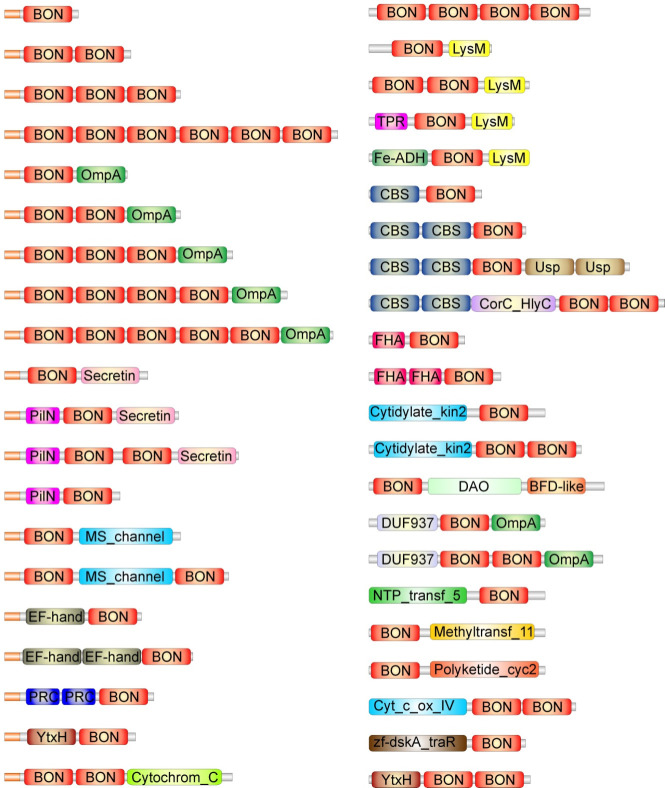
BON domain (Pfam: PF04972) containing proteins.The Pfam database was interrogated for the presence of proteins containing BON domains. BON domains are widely distributed in bacteria and eight major architectures are noted (Table 1). The predominant architecture is that observed for DolP and OsmY where the protein possesses a signal sequence and one or more BON domains. The second major architecture is that observed for Kbp, where proteins possess one or more BON domains and a LysM domain. The other major architectures include associations with Secretin (Pfam: PF00263), CBS (Pfam: PF00571), OmpA (Pfam: PF00691), MS_channel (Pfam: PF00924), FHA (Pfam: PF00498) or cytidylate kinase (Pfam: PF13189) domains. Due to their functions, many of these domains would place their associated BON domains in proximity to cell membranes.